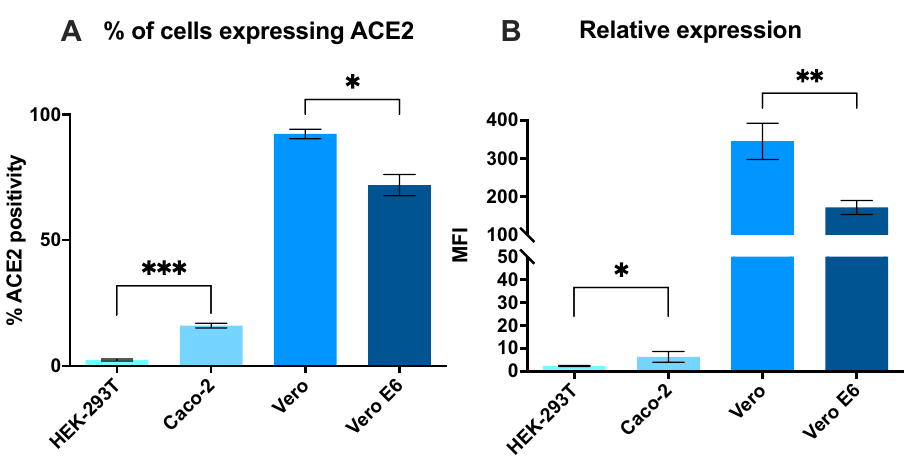
Figure 3. Expression of ACE2 on the surface of HEK-293 T, Caco-2, Vero, and Vero E6 cells. ( A ) Proportion of cells expressing ACE2 ( B ) Relative expression of ACE2 on cell surface as expressed by median fluorescence intensity (MFI) of ACE2-AF647. Average of 3 separate experiments done in duplicate with standard deviations shown. p < 0.05 (*), p < 0.01 (**), p < 0.001